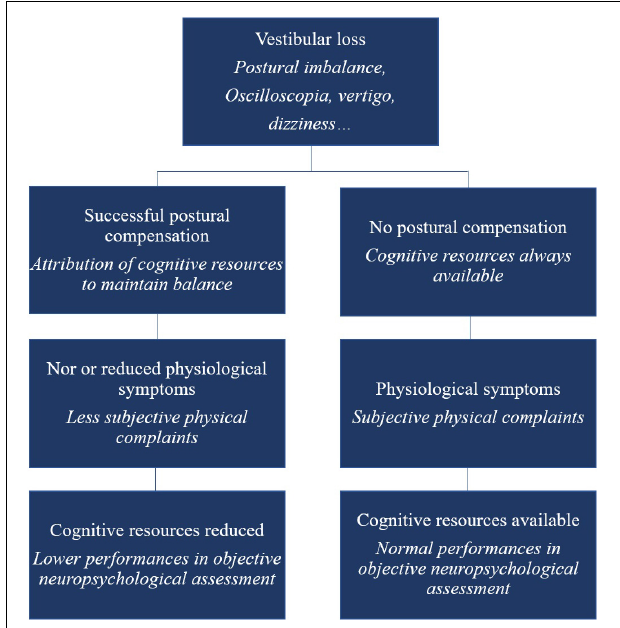
FIGURE 1 | Schematic overview of the cognitive-vestibular compensation hypothesis – adaptation of the Kahneman’s Capacity Model of Attention to vestibular-damaged